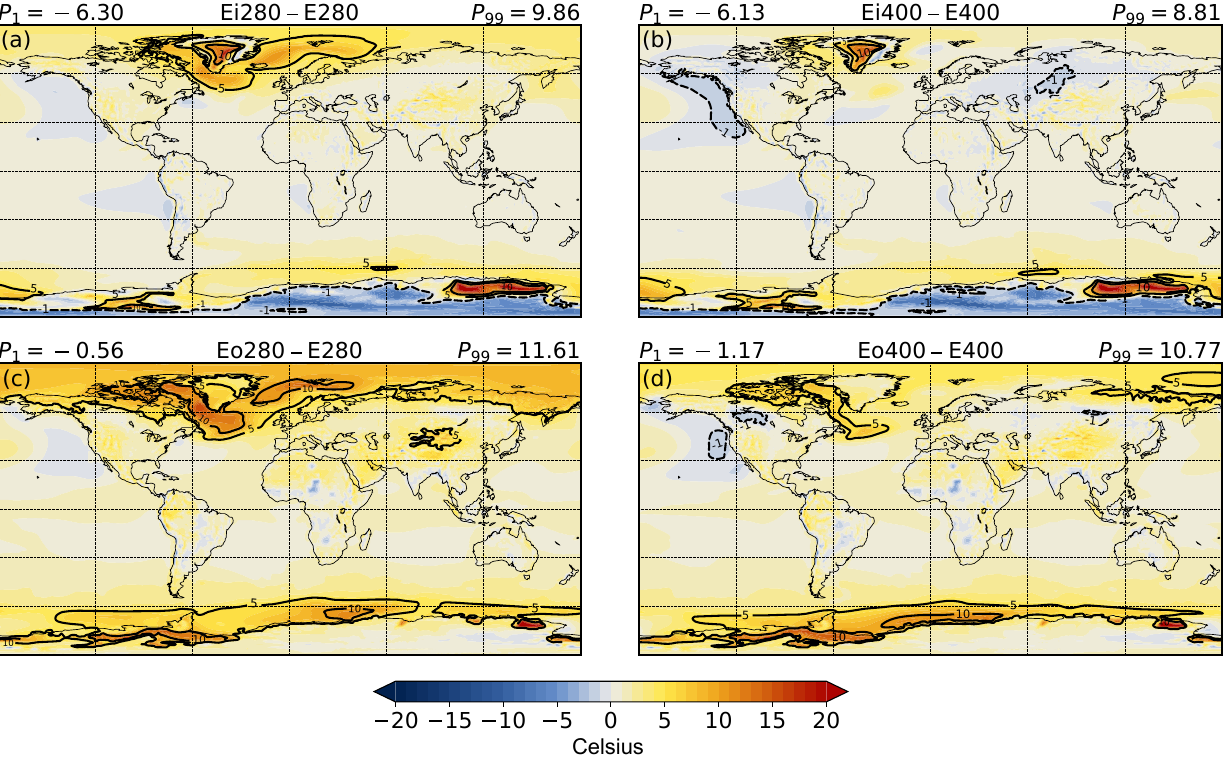
Figure 5. Climatological MASAT anomalies of the Ei and the Eo sensitivity experiments with respect to controls. The control experiment is chosen such that the p CO 2 is identical between the sensitivity experiment and the control. The left column shows the anomalies for the 280ppmv p CO 2 experiments and the right column shows the anomalies for the 400ppmv p CO 2 experiments. The 1st and the 99th percentiles of the anomalies are shown above each panel. The climatology years are noted in Table 2.